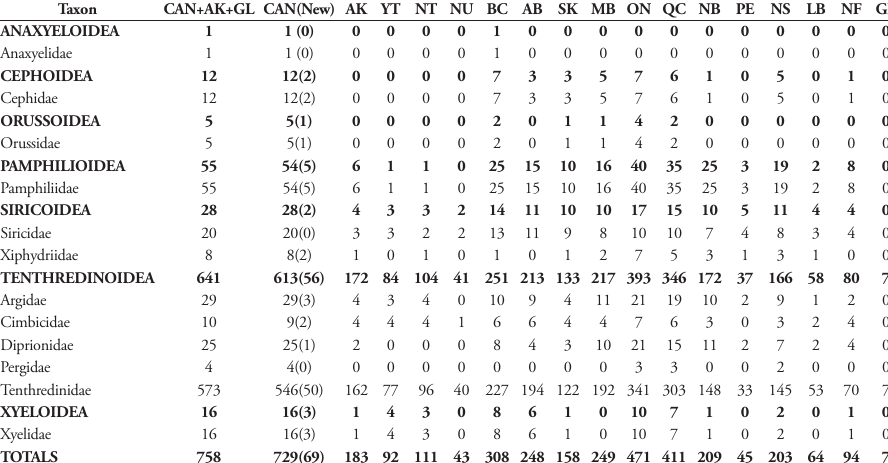
Table 1. Described, recorded species of sawflies in Canada, Alaska and Greenland totalled for each taxon and in each region. See Methods (Presentation of data) for description of distributional acronyms and Fig. 1 for a map of their locations. Northwest Territories (NT) and Newfoundland (NF) totals each include six ambiguous records that may have been collected in Nunavut (NU) or Labrador (LB), respec- tively (denoted by NT* and NF* in Table 2).